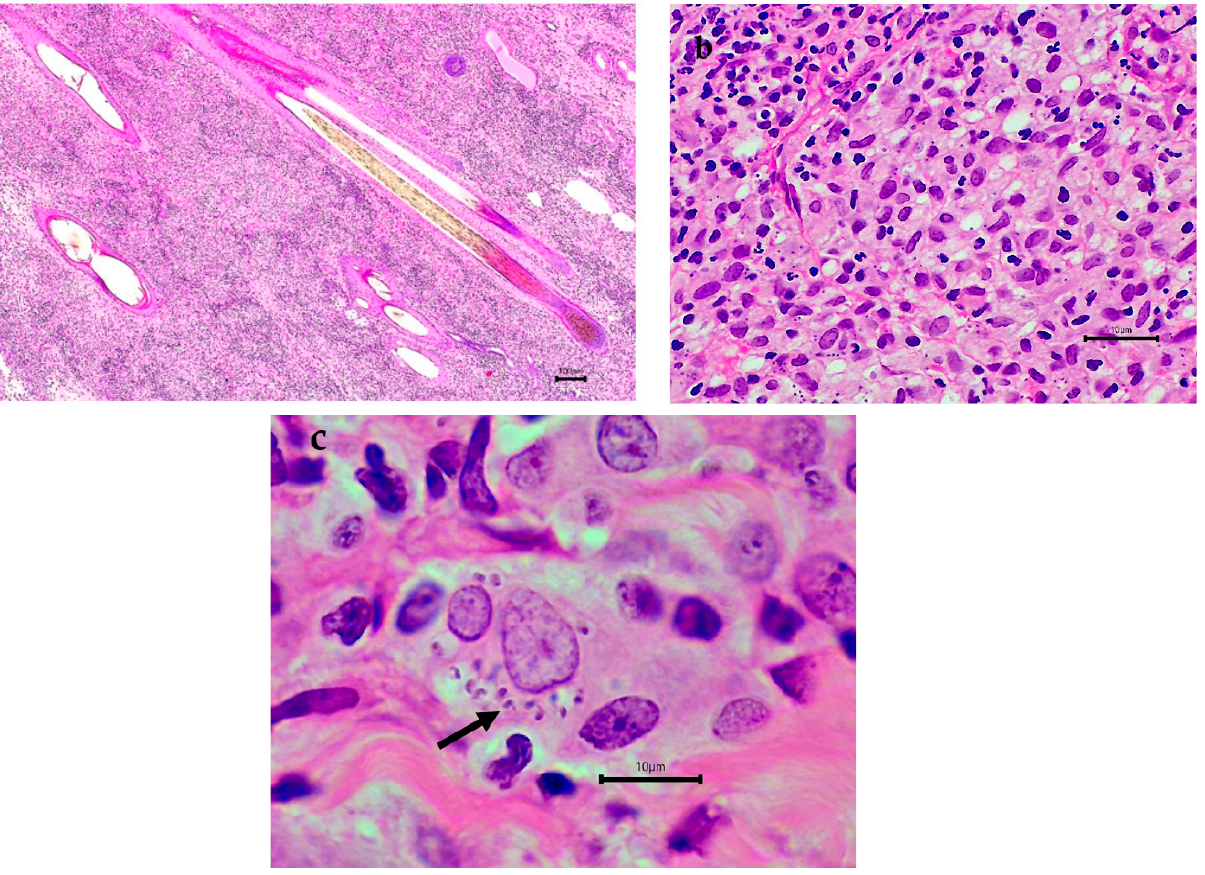
Figure 2. Nail bed skin histopathology from dog 1 collected in 2015: ( a ) Granulomatous dermatitis. Haematoxylin and eosin staining; bar = 100 um. ( b ) Granulomatous dermatitis with macrophages admixed with neutrophils and fewer plasma cells and lymphocytes. Haematoxylin and eosin staining; bar = 10 um. ( c ) Multiple Leishmania amastigotes within the cytoplasm of a macrophage. Arrow points to a kinetoplast at right angles to the amastigote nucleus. Haematoxylin and eosin staining; bar = 10 um.